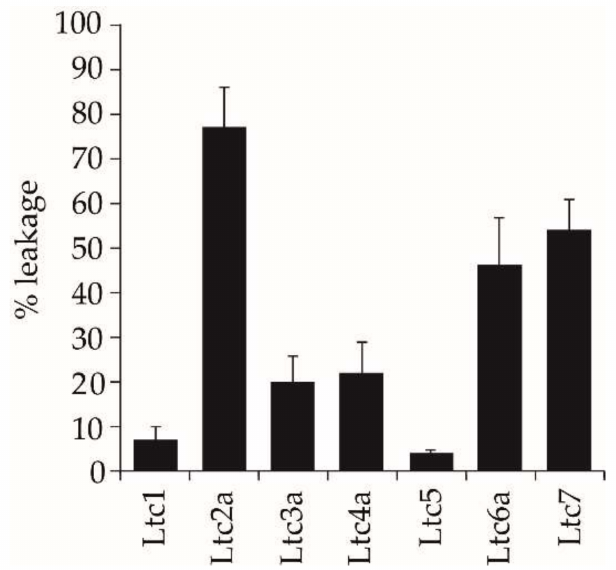
Figure 5. Peptide-induced leakage of ANTS/DPX in large unilamellar vesicles made of POPC/POPG (1/1) lipids at a P/L of